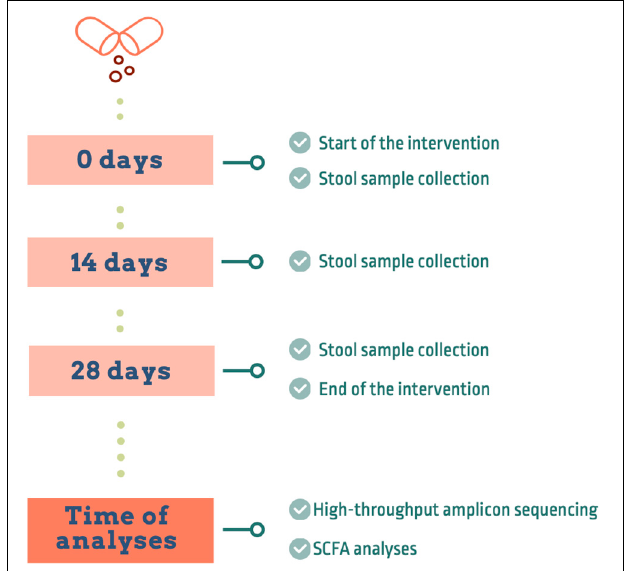
FIGURE 1 | Design of the intervention